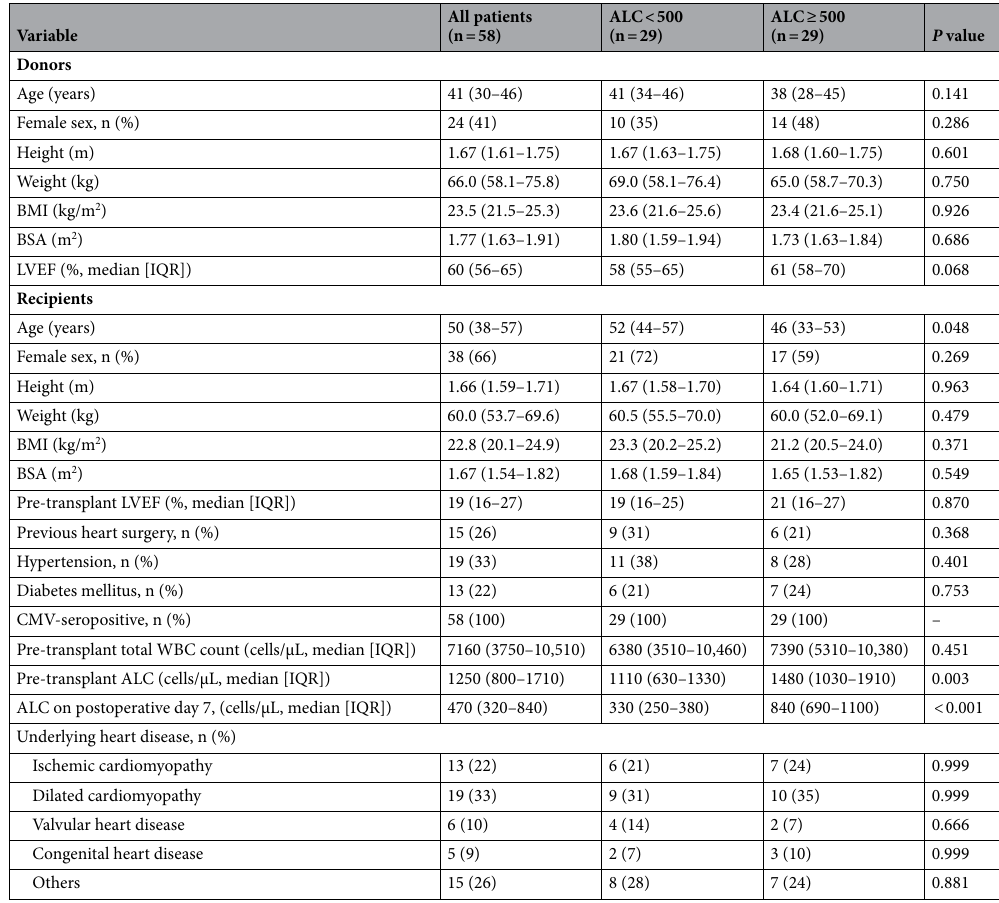
Table 1. Baseline characteristics of the study population stratified by the ALC on POD #7. Values are expressed in numbers (%), or median (interquartile range). ALC = absolute lymphocyte count, BMI = body mass index, BSA = body surface area, CMV = cytomegalovirus, POD = postoperative day, WBC = white blood